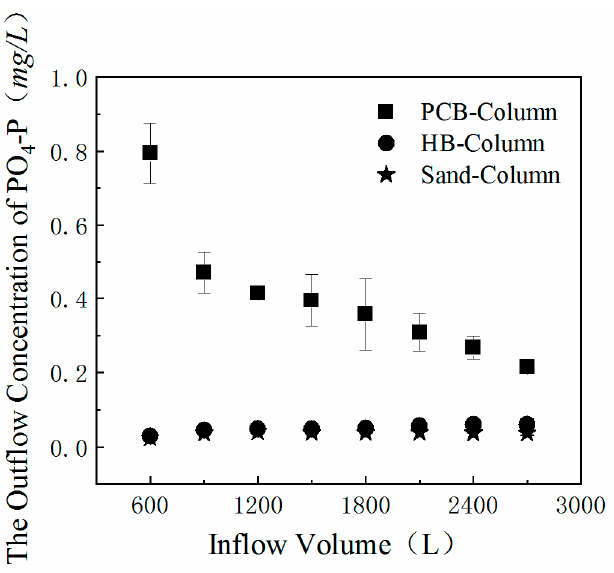
Figure 7. Concentration of PO 43 − in outflows from the three columns in the first simulated rainfall event.